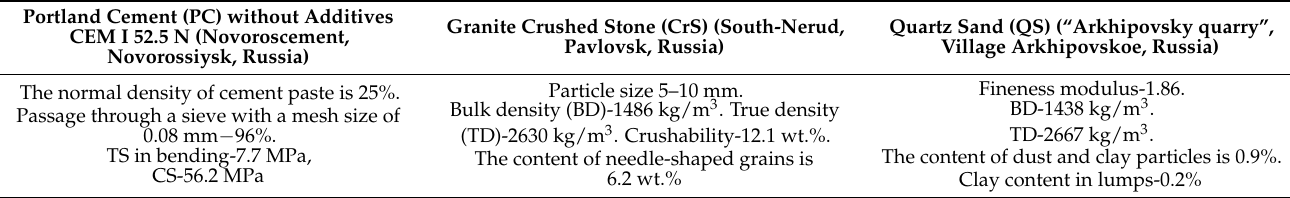
Table 2. Raw material characteristics for the CMs manufacture.